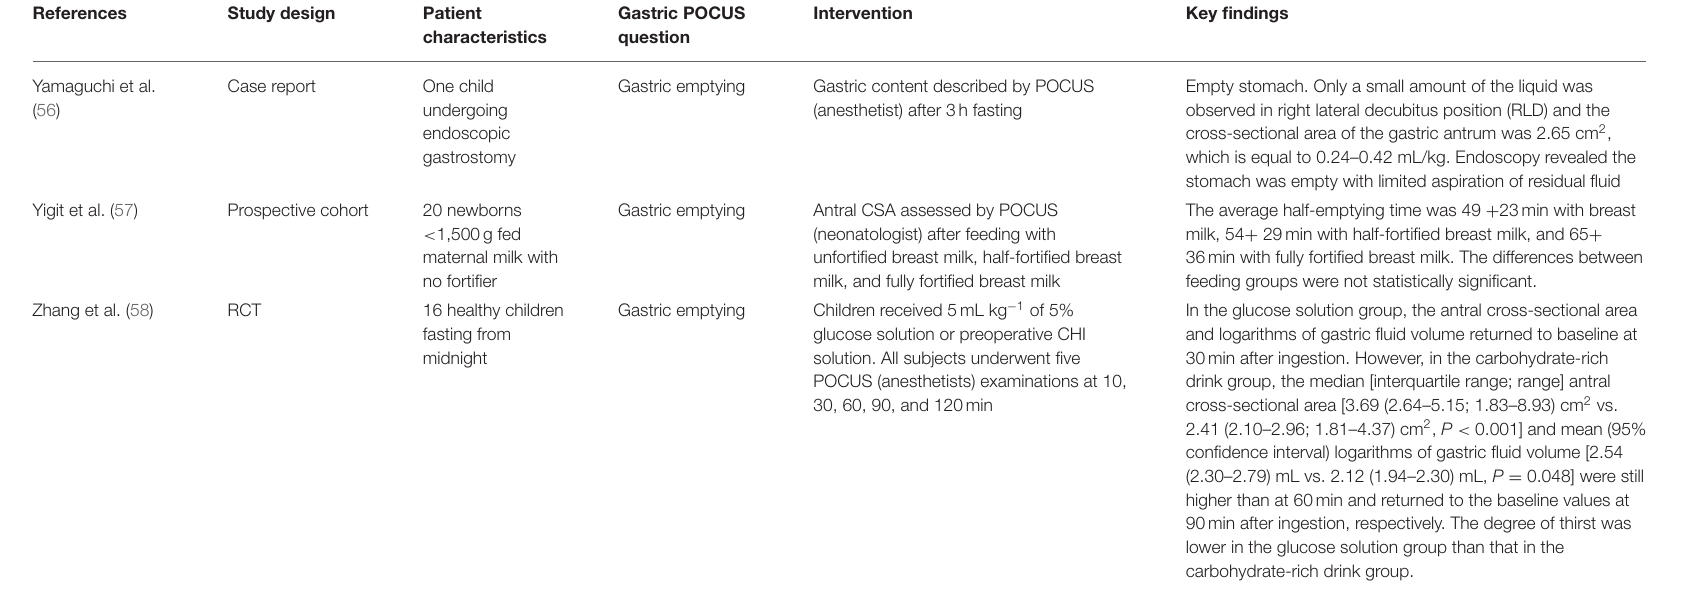
POCUS, point-of-care ultrasound; RADUS, radiologist ultrasound; AUC, area under the curve; CSA, cross-sectional area; EBM, expressed breast milk; ED, emergency department; ENT, ear nose and throat; GAA, gastric antral area; GCV, gastric corrected volume; GFV, gastric fluid volume; GRV, gastric residual volume; HMF, human mother milk; MRI, magnetic resonance imaging; NICU, neonatal intensive care unit; OR, operating room; RCT, randomized controlled trial; RLD, right lateral decubitus; TGV, total gastric